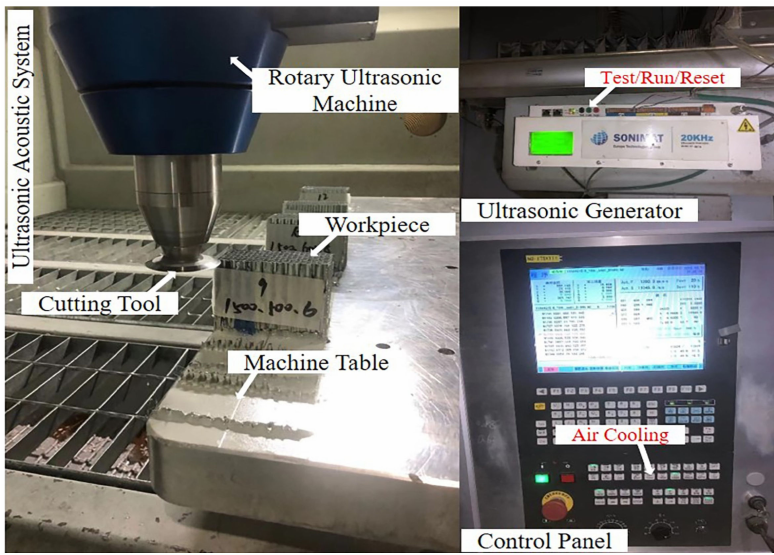
Figure 2. Experimental equipment of ultrasonic machining system for ALHCs core